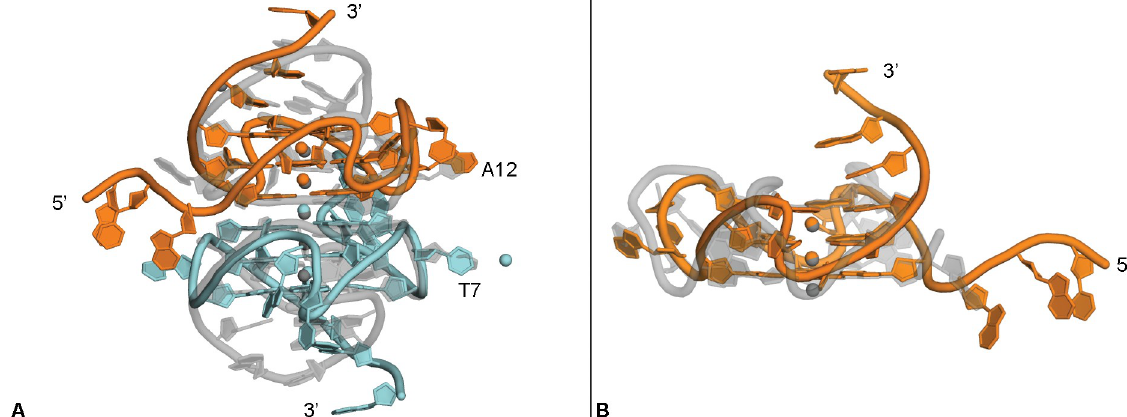
Fig 8. Comparison to other quadruplex crystal structures. Overlay of c-KIT crystal structure (PDB:4WO2, grey) with strand A (orange) and strand B (cyan) of the c-MYC promoter crystal structure; loop residue labels correspond to c-MYC crystal structure (A). Overlay of human telomeric crystal structure (PDB: 4FXM, grey, ligand not shown) with strand A (orange) of the c-MYC promoter crystal structure (B).